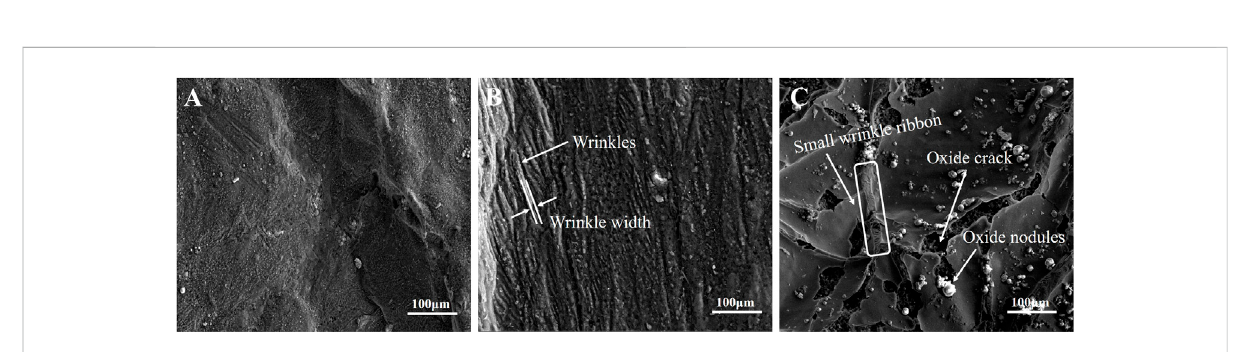
FIGURE 2 The surface morphologies of oxide scale formed on the